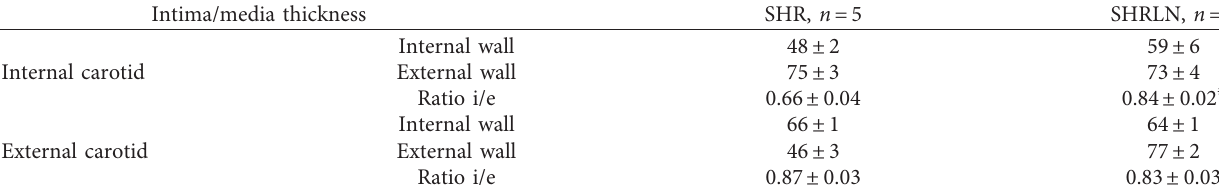
Table 3: Carotid sinus histological